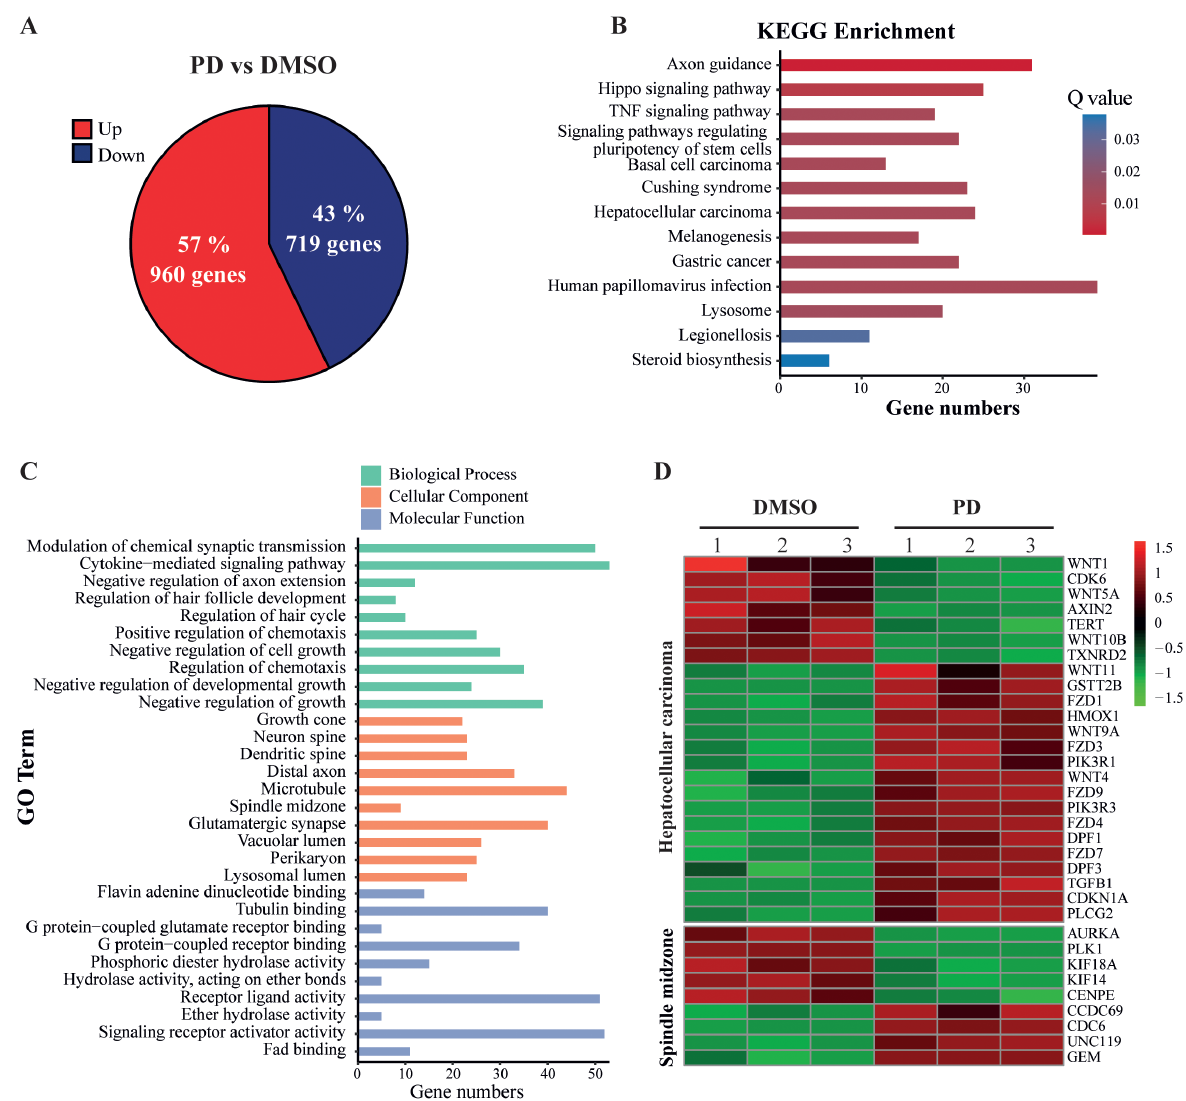
Figure 4. Analysis of differentially expressed genes based on RNA-seq data of HepG2 cells treated with PD. ( A ) Up- and down-regulated genes in PD-treated HepG2 cells. Collectively, 1679 genes were significantly and differentially expressed, with 960 genes upregulated (red) and 719 genes downregulated (blue) in PD-treated HepG2 cells compared to the DMSO-treated cells. ( B ) The altered signaling pathways in the KEGG enrichment analysis. ( C ) Gene Ontology (GO) enrichment of differentially expressed genes. GO contains three independent GO categories. The three indicated processes include the biological process (BP), molecular function (MF) and cellular component (CC). ( D ) The heatmap of the DEGs involved in hepatocellular carcinoma (HCC) development and spindle midzone formation.